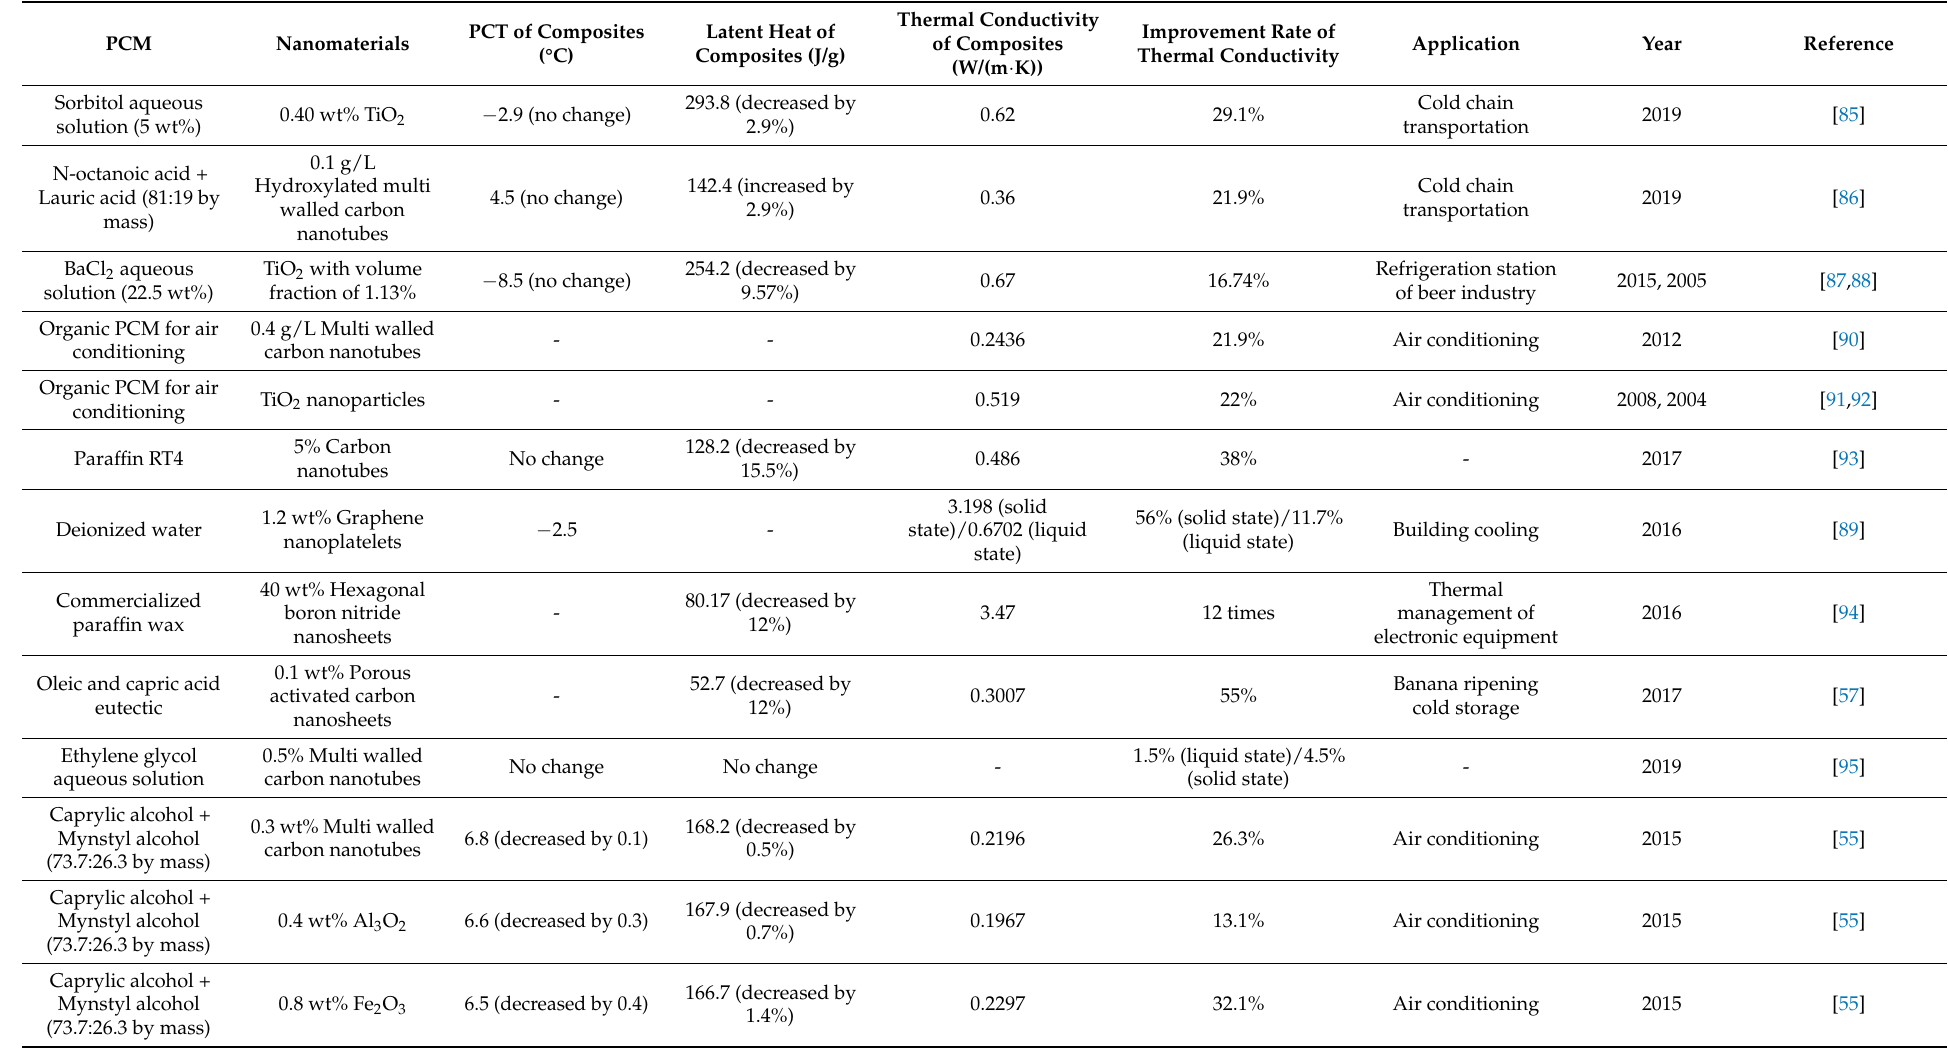
Table 6. Typical cases of adding nanomaterials to enhance the thermal conductivity of